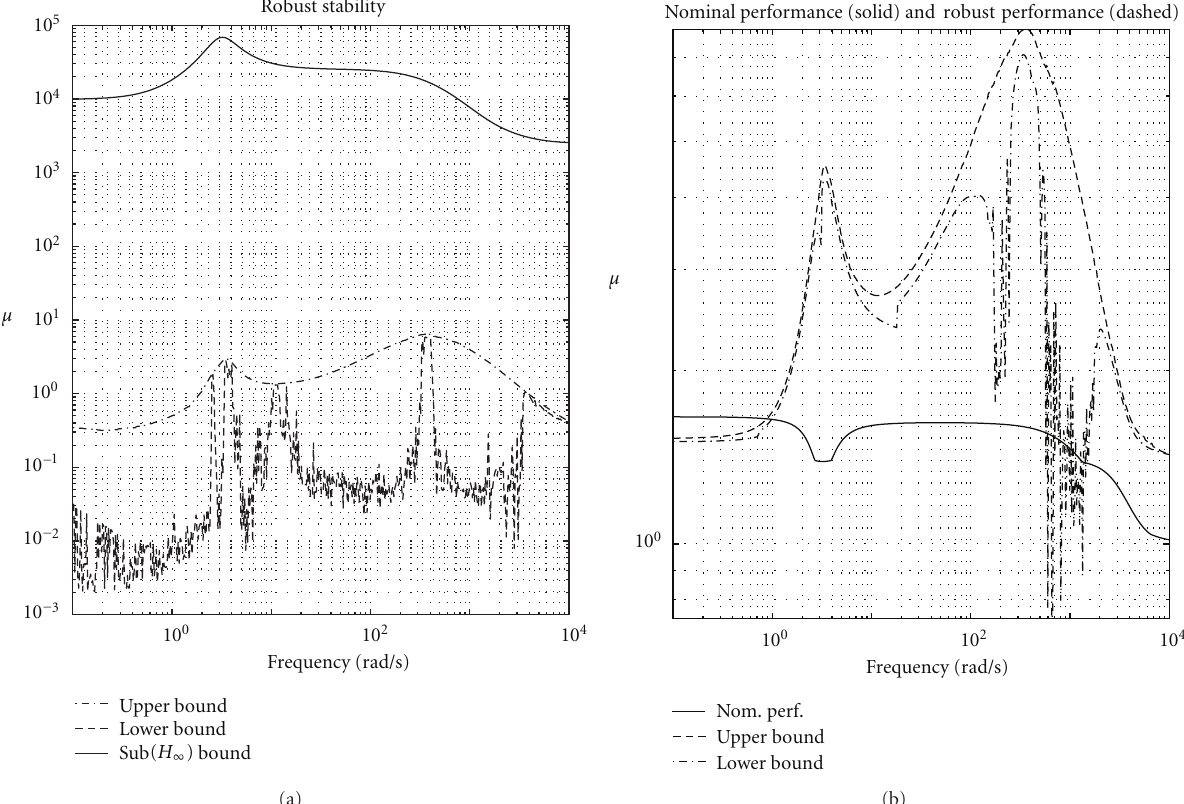
Figure 9: Robust stability, nominal and robust performance function described by μ -value with Sub( H ∞